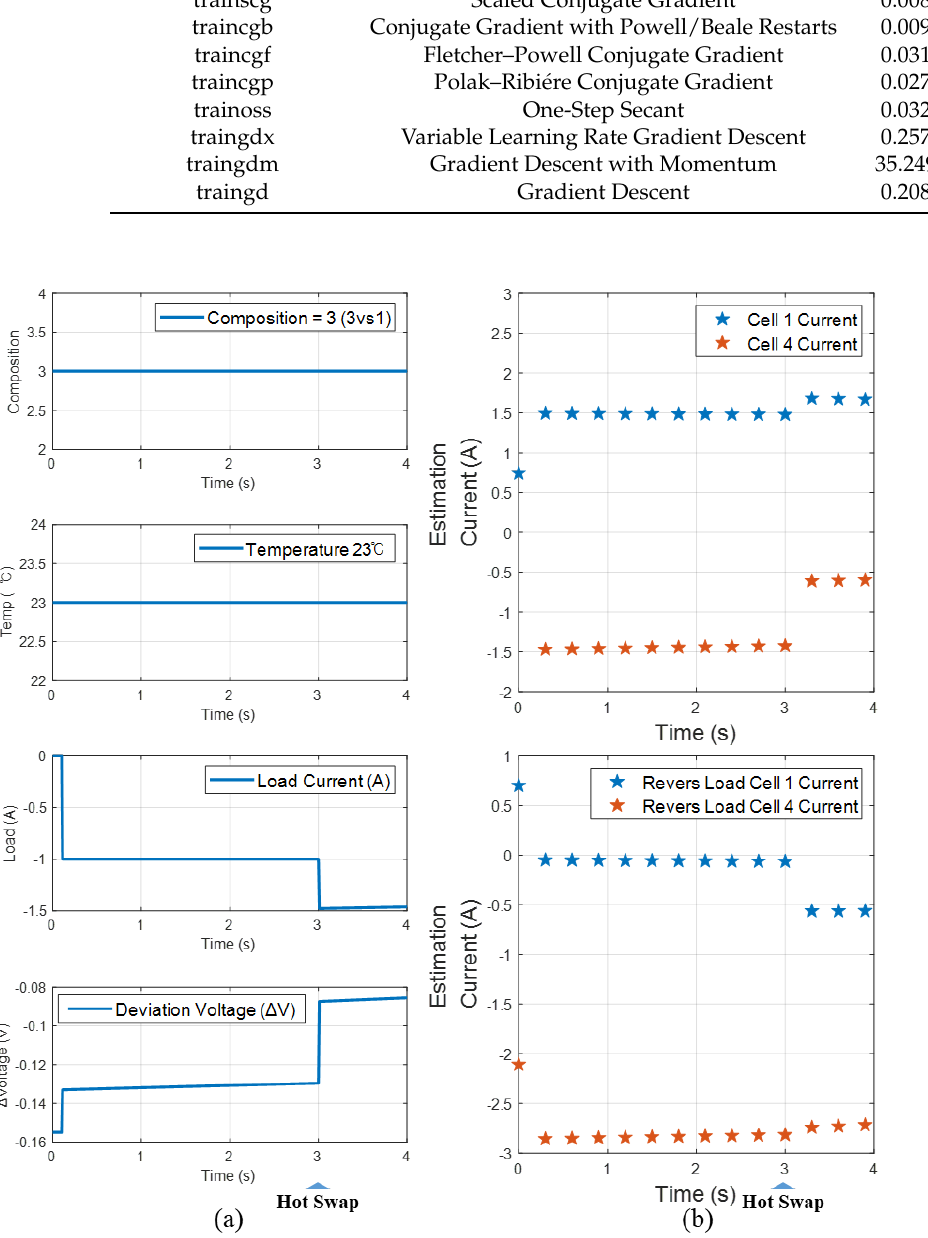
Figure 16. Verification of the results obtained for the hot-swap circulating current with the ANN model. ( a ) ANN input data, ( b ) ANN Estimation Circulation Current. Table 8. Comparison of ANN model with simulation results.